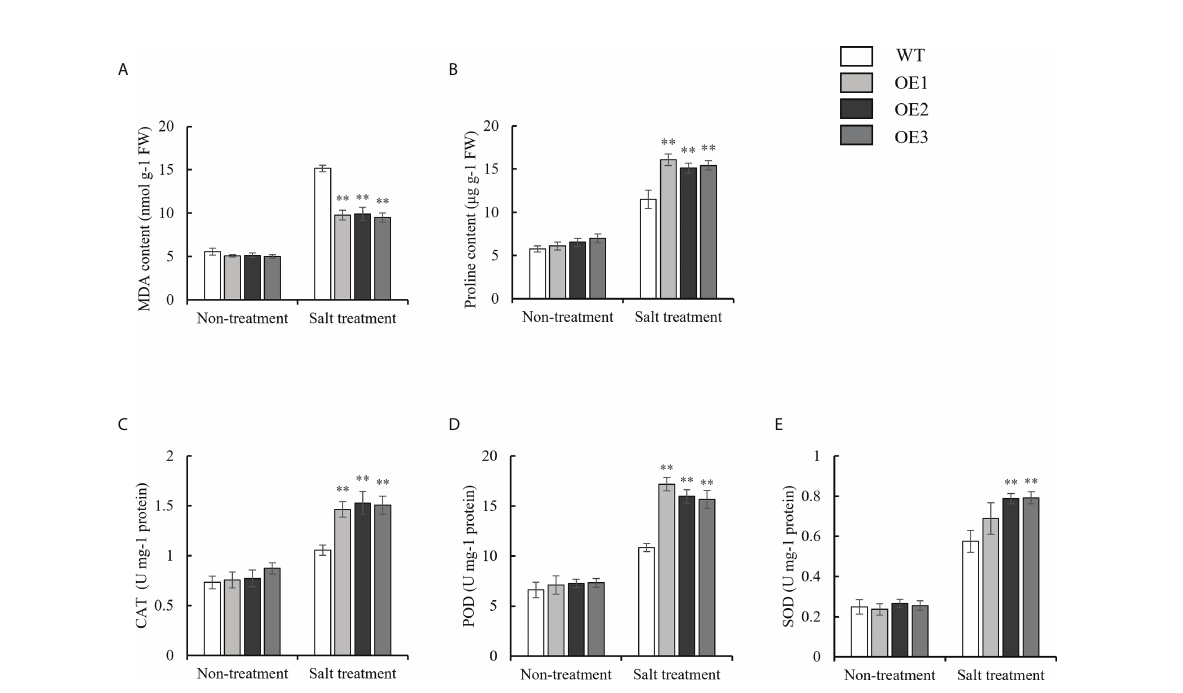
FIGURE 7 Evaluation of physiological indices of OE lines and WT responsive to salt stress. (A) MDA content. (B) Proline content. (C-E) Alterations of Activities of CAT, POD, and SOD. Standard deviations are indicated by error bars (mean ± SD and n = 3). Student ’ s t-test was used to calculate signi fi cance: ** indicates p >